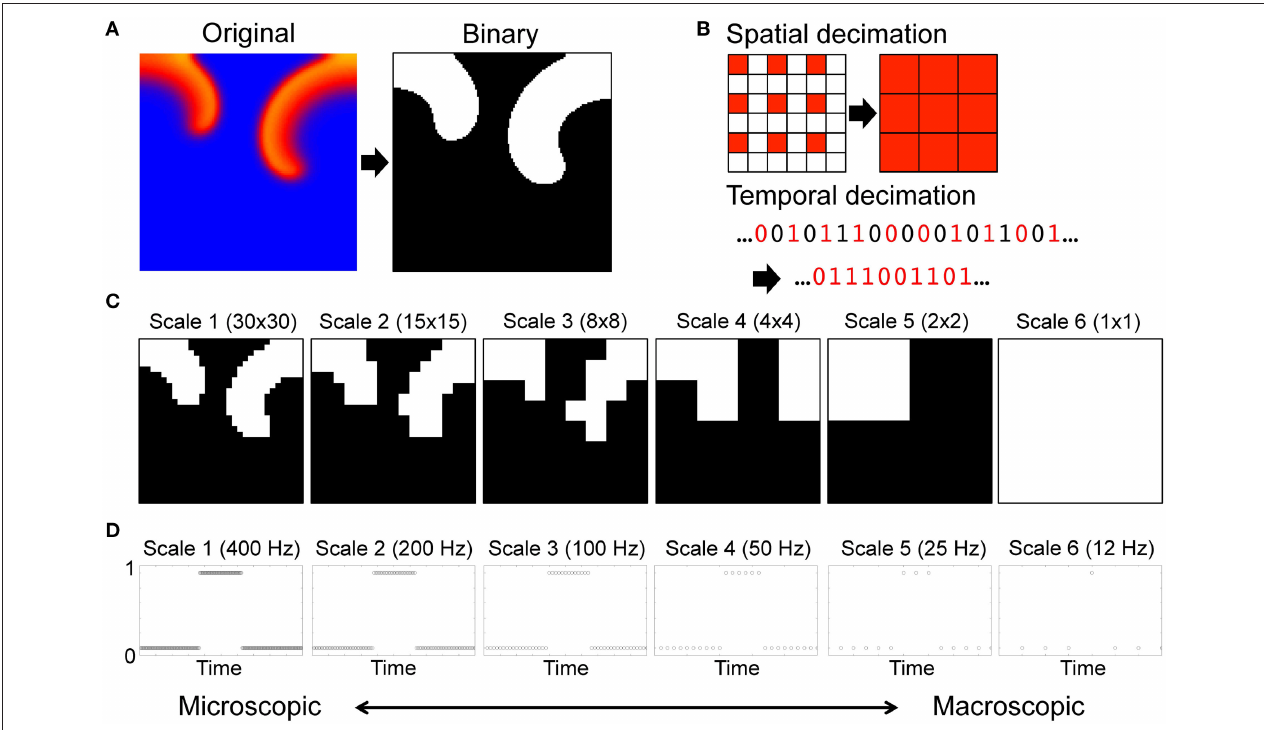
FIGURE 1 | Renormalization of a cardiac system with spiral waves. (A) Original description of the system. For each component, the time series of cardiac excitation is descretized to 1 (black) when excited (during the APD at 90 % repolarization, or APD 90 ) or 0 (white) when resting. (B) Spatial and temporal decimation. Spatial decimation takes the value of cardiac excitation (0 or 1) at each time point in the component at the top left corner of a block of 2 × 2 immediately adjacent components of the system, and assigns the value to the corresponding site in the system at the next scale. Temporal decimation downsamples the time series of cardiac excitation by a factor of 2. (C) Spatial scales. Spatial scales include scale 1 (30 × 30 lattice), scale 2 (15 × 15 lattice), scale 3 (8 × 8 lattice), scale 4 (4 × 4 lattice), scale 5 (2 × 2 lattice), and scale 6 (1 × 1 lattice). (D) Temporal scales. Each circle represents a data sampling point. Temporal scales include scale 1 (400 Hz), scale 2 (200 Hz), scale 3 (100 Hz), scale 4 (50 Hz), scale 5 (25 Hz), and scale 6 (12